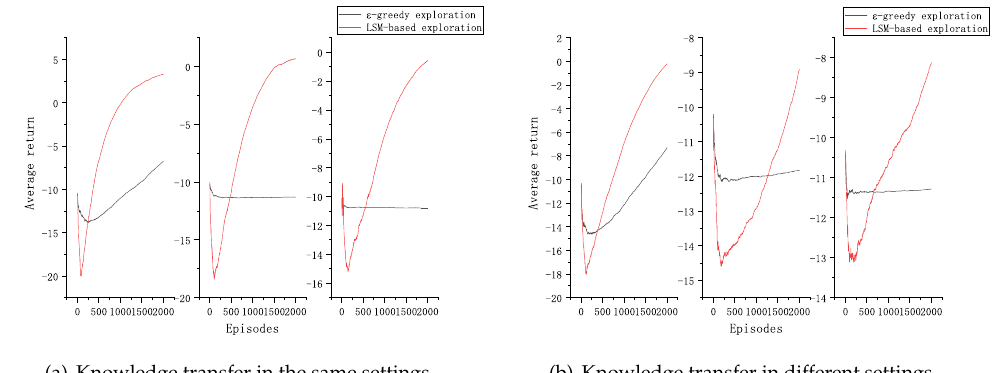
Figure 5. The learning curves of LSM-based and (cid:101) -greedy exploration strategies with different values of (cid:101) ( 0.9, 0.7, and 0.5 from left to right). The curves are smoothed with a window of 100 episodes with an error bar at every 100 episodes.